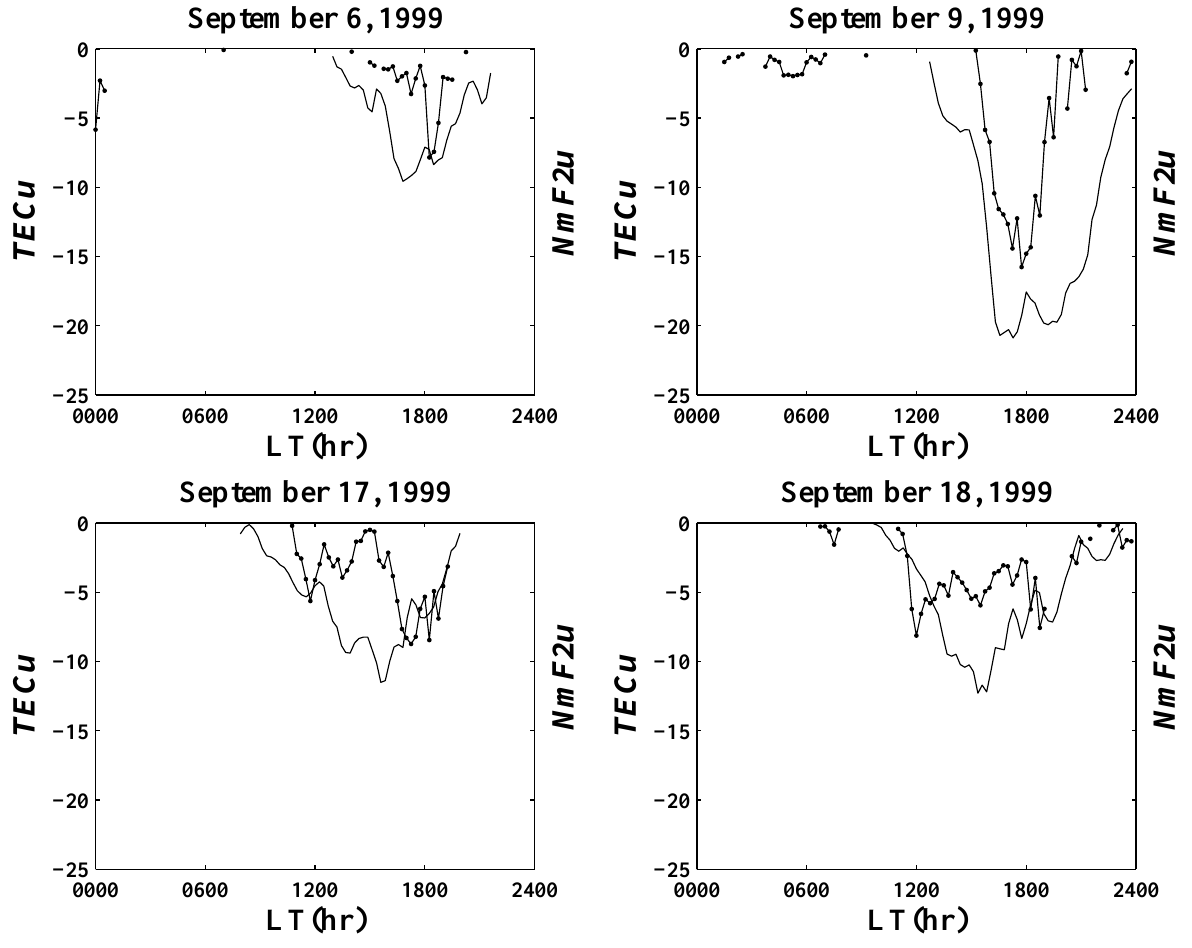
Fig. 3. The strength of four pre-earthquake ionospheric anomalies in Nm F2 (dotted lines) and V T EC (solid lines) appear on 6, 9, 17 and 18 September 1999. The strength is defined as the departure of the observed quantities from the associated